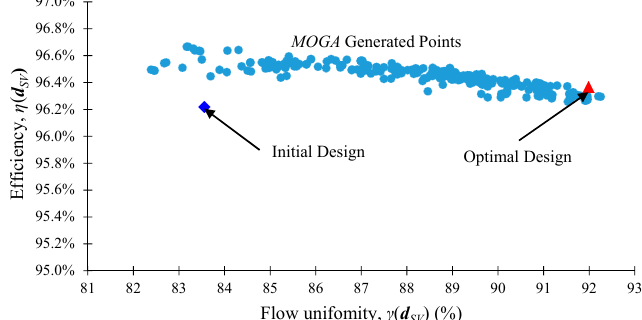
Figure 8. Pareto front for the optimization of stay vane design.